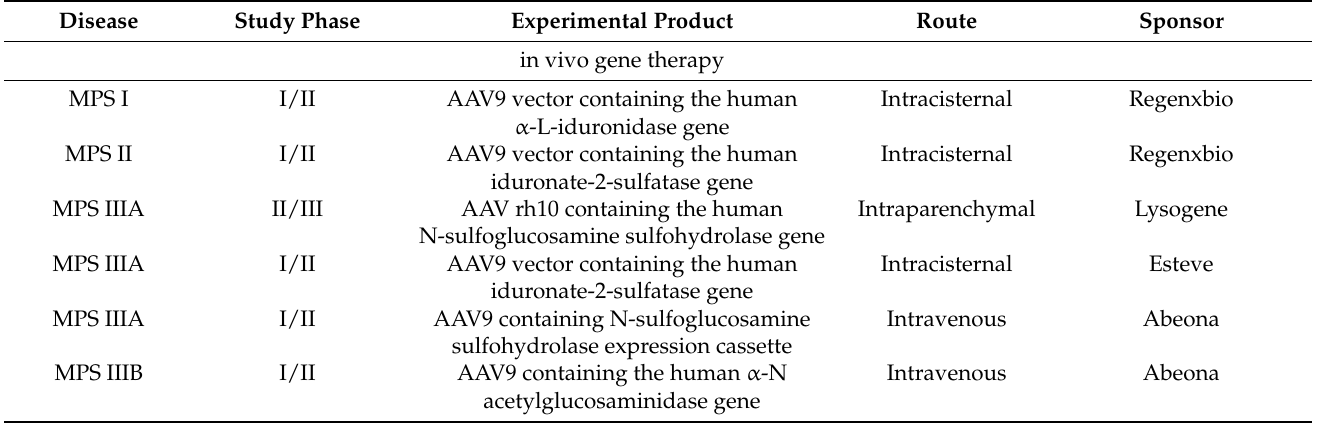
Table 1. Clinical trials of ex vivo and in vivo gene therapy (GT) for neuronopathic MPS.